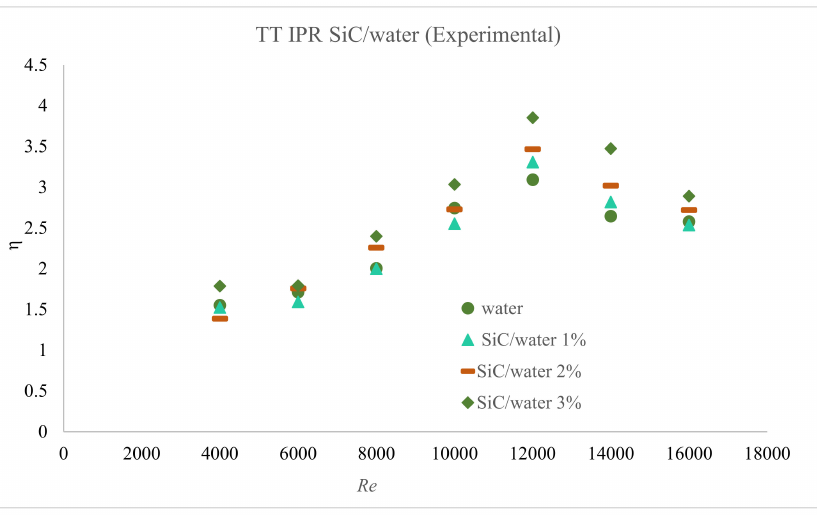
Figure 29. E ff ect of the nanofluid volume fraction ϕ on η